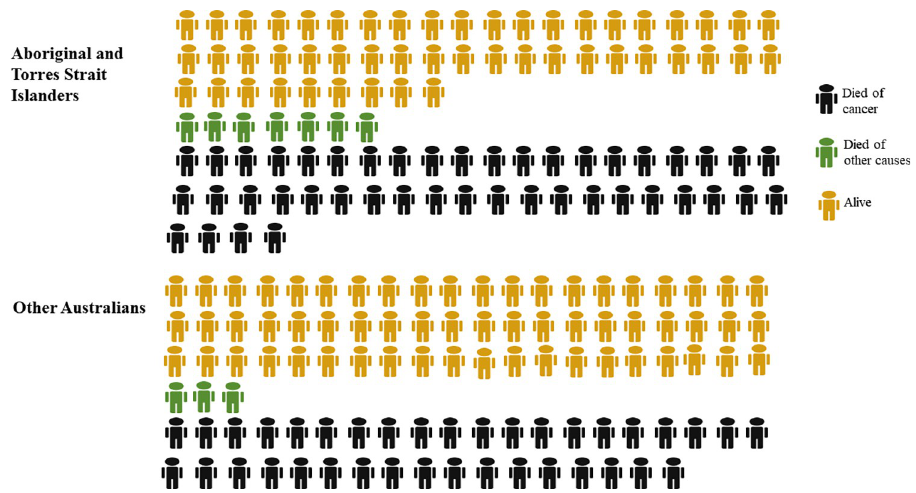
Fig 2. Five-year crude probability of death from cancer, death from other causes and being alive, for all cancers combined by Aboriginal and Torres Strait Islander status, Australia, 2005–2016.